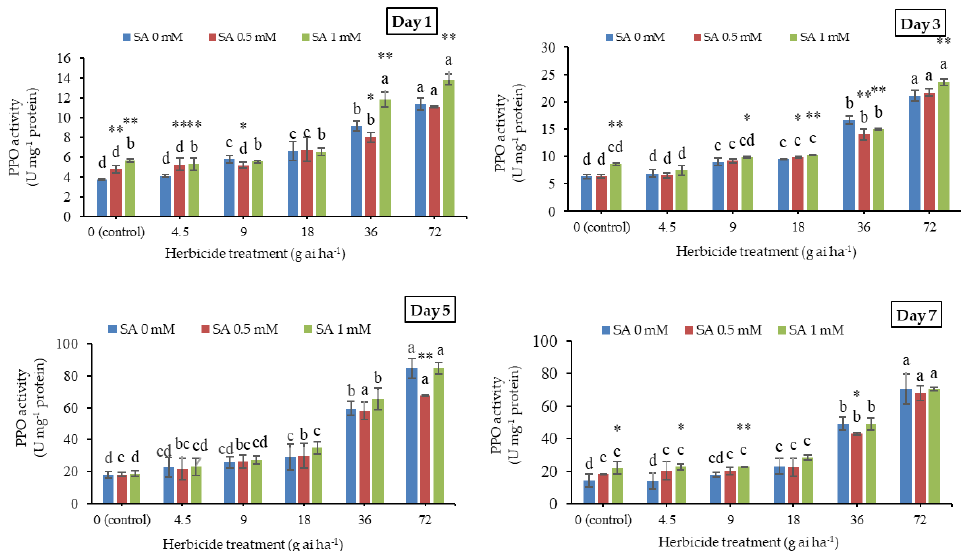
Figure 8. Changes in polyphenol oxidase (PPO) activity in the leaf tissues of wheat at 1, 3, 5, and 7 days after herbicide application at different rates. The leaves were pre-treated with different con- centration of salicylic acid (SA) 3 days prior to herbicide application. The bars represent the treat- ment mean ± SD ( n = 4), and the bars with different lower-case letters were significantly ( p ≤ 0.05) different, according to the Duncan ’ s test. Asterisks indicate significant difference between the herb- icide only and herbicide with each concentration of SA, according to the Independent Samples t -test.